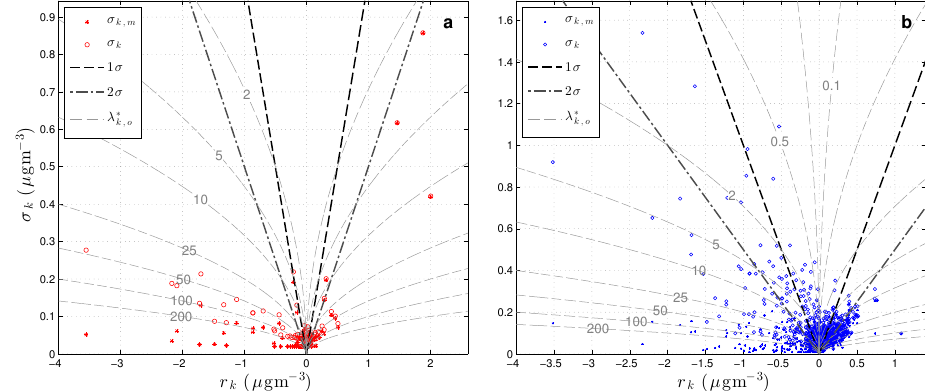
) contours corresponding k,o